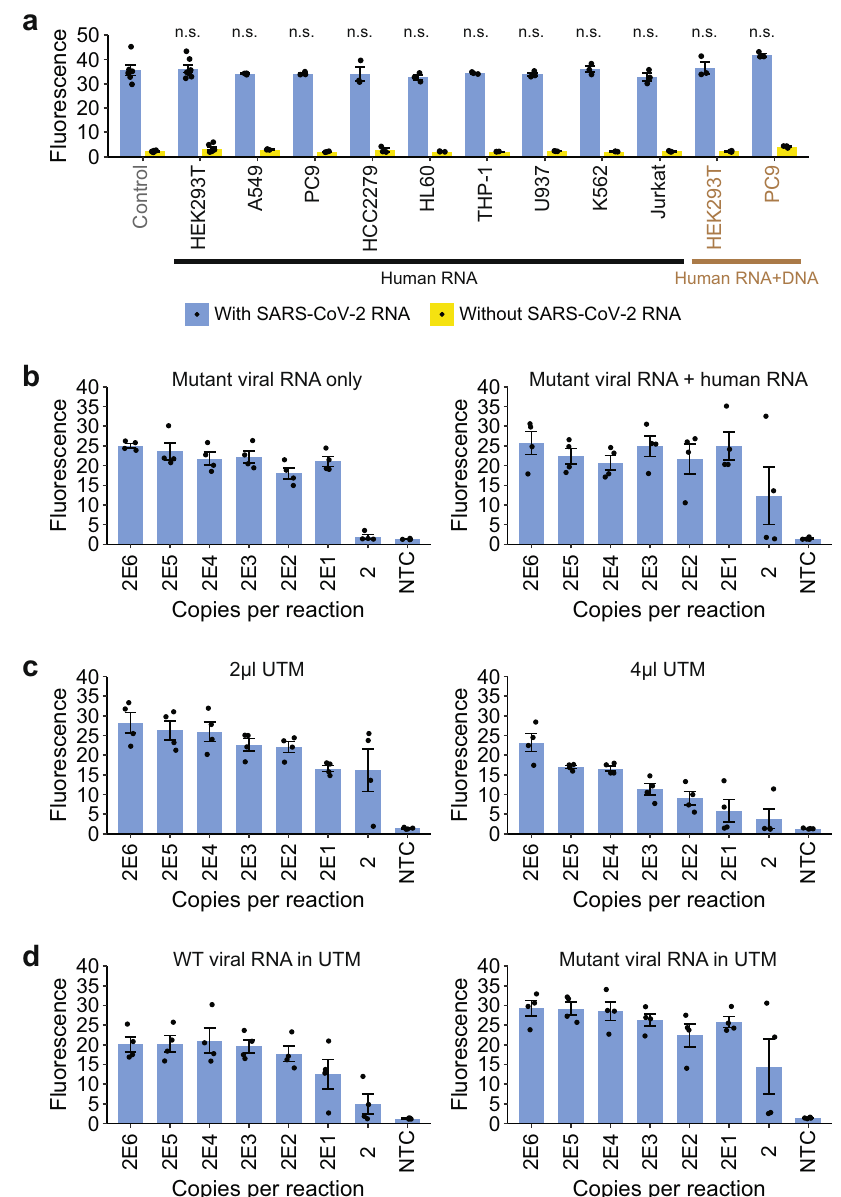
Fig. 5 Evaluation of the VaNGuard test under more realistic conditions. a 20,000 copies of synthetic SARS-CoV-2 RNA fragments were spiked into 10 ng of total RNA extracted from different immortalized human cell lines to mimic infection in various cell types [HEK293T: adrenal precursor, A549: lung, PC9: lung, HCC2279: lung, HL60: blood (promyelocytes), THP-1: blood (monocytes), U937: blood (monocytes), K562: blood (granulocytes/ erythrocytes), and Jurkat: blood (T cells)]. Pure synthetic viral RNAs were used as a control. The control or spiked RNA samples served as input to RT-LAMP, which was performed at 65 °C for 15 min. The Cas detection reaction was then carried out at 37 °C, with fl uorescence after 30 min shown. Data represent mean ± s.e. m. ( n = 3 [all except control and HEK293T RNA], 6 [control], or 7 [HEK293T RNA] biological replicates). There was no signi fi cant loss of signal in the presence of human RNA (n.s.: not signi fi cant, P > 0.2; one-sided Student ’ s t -test). b Analytical LoD for a S254F N234N double mutant RNA template either by itself or mixed with 10 ng total human RNA from HCC2279 cells. Different copies of synthetic viral template (with or without human RNA) were used as input to RT-LAMP, which was performed at 65 °C for 15 min. The Cas detection reaction was then carried out at 37 °C, with fl uorescence after 10 min shown. Data represent mean ± s.e.m. (n = 4 biological replicates). c Analytical LoD for puri fi ed synthetic wild-type SARS-CoV-2 RNA template in the presence of 2 µ l or 4 µ l UTM. Data represent mean ± s.e.m. ( n = 4 biological replicates). d Analytical LoD for wild-type (WT) or S254F N234N double mutant RNA template mixed with 10 ng total human RNA from HCC2279 cells in the presence of 2 µ l UTM. Data represent mean ± s.e.m. ( n = 4 biological replicates). Source data are available in the Source Data fi